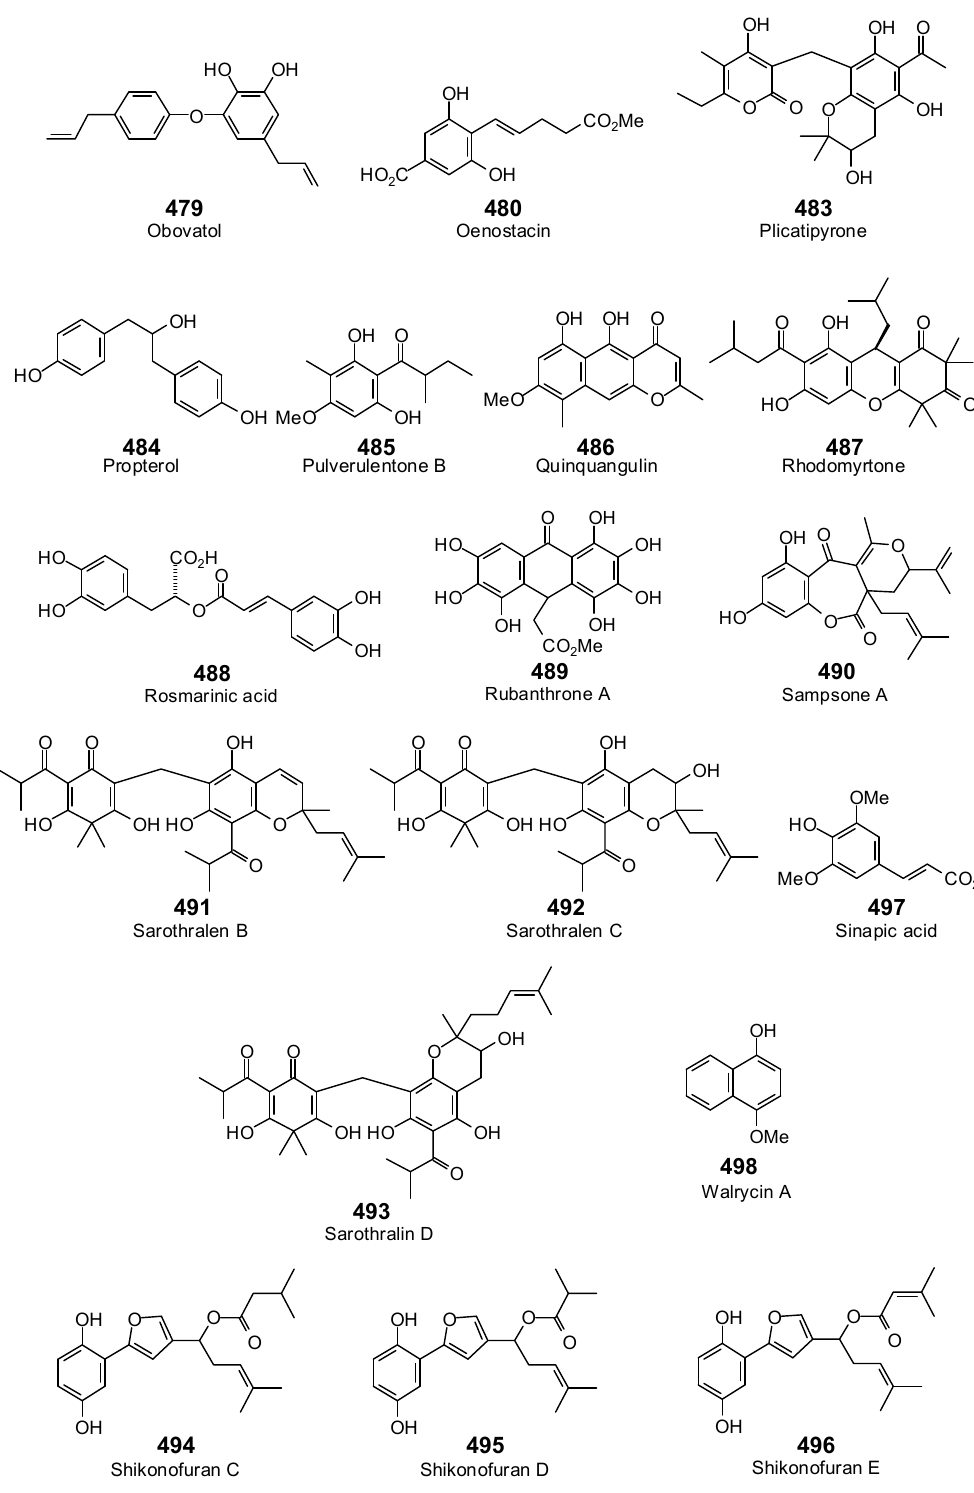
Figure 21. Miscellaneous phenolic phytochemicals examined in this work.